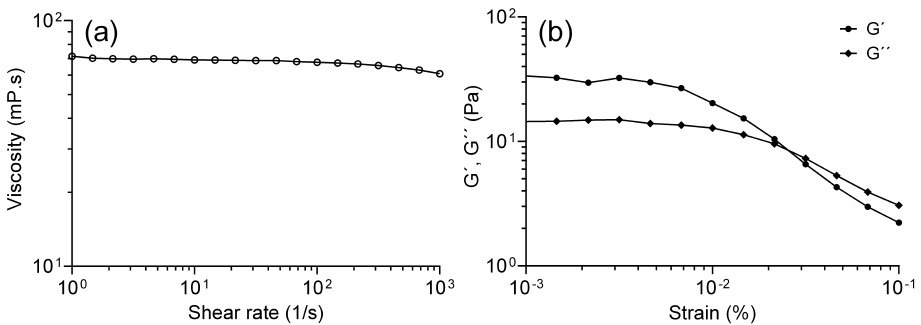
Figure 1. ( a ) Viscosity curves and ( b ) elastic (G ′ ) and viscous modulus (G ″ ) of the pectin − based hydrogel enriched with allantoin.